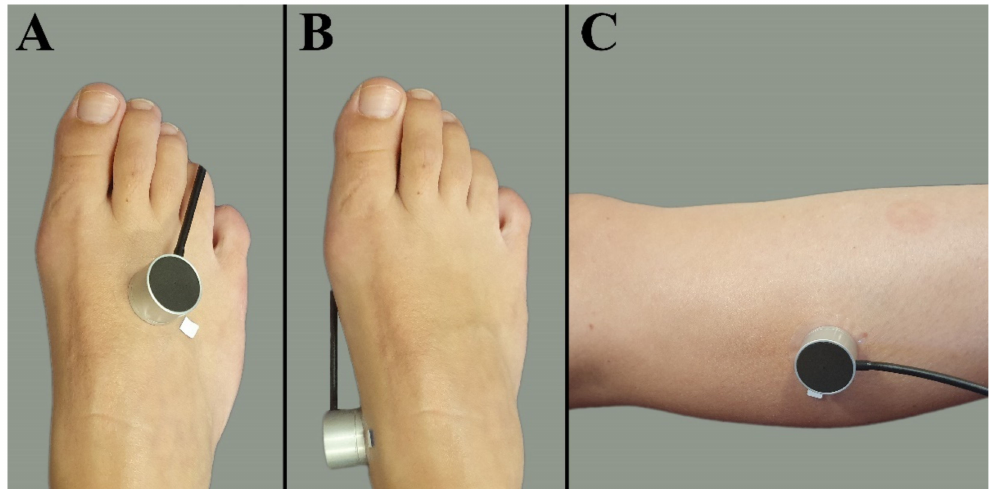
Figure 1. Measurement locations at the lower extremity. ( A ) Dorsal side of the foot. ( B ) Medial side of the foot. ( C ) Lateral side of the calf muscle 5 cm distally from the fibular head.